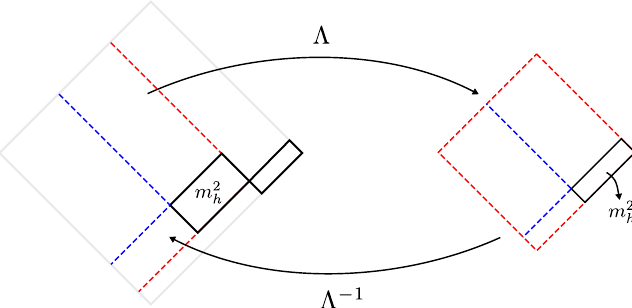
Figure 6: Illustration of Lorentz boosting ( Λ ) from the lab frame to the string center- of-mass frame. Red and blue lines are the string system’s longitudinal momentum with the total area equal string system’s longitudinal momentum E + p a new